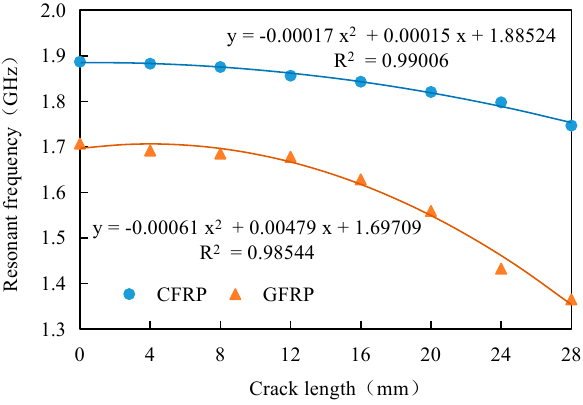
Figure 10. Experimental results for CFRP and GFRP.